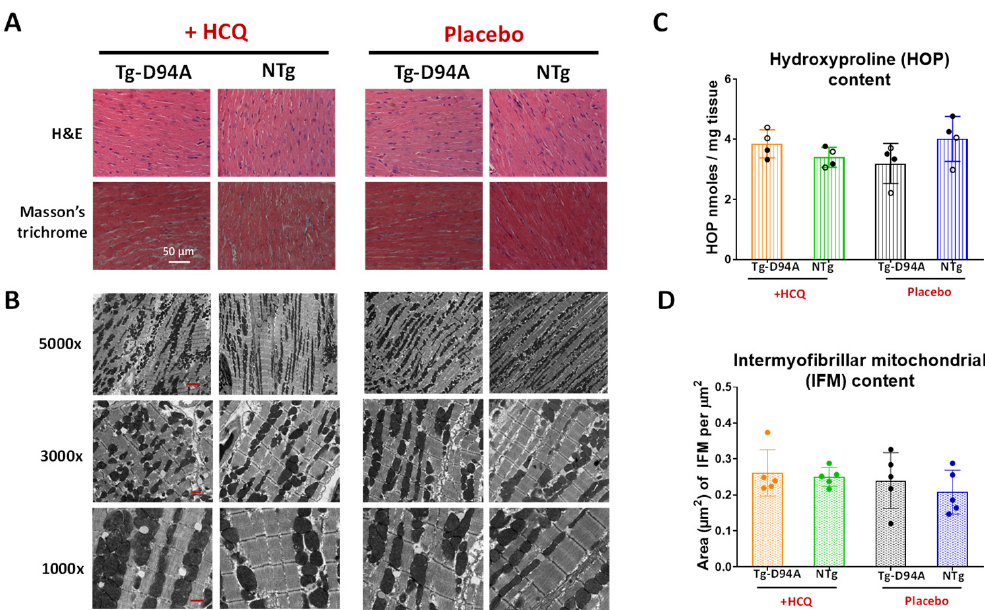
Figure 5. Histopathology and myocardial ultrastructure of the hearts of 6-mo-old Tg-D94A vs. NTg female mice treated with HCQ- vs. placebo. ( A ) Left ventricular (LV) samples stained with hematoxylin and eosin (H&E, upper panel) and Masson’s trichrome (bottom panel). ( B ) Transmission electron microscopy (TEM) images of sarcomeric ultrastructure of LV tissue of Tg-D94A and NTg mice. Images were taken at 1000×, 3000×, and 5000× magnification with scale bars of 4 µm, 1 µm, and 800 nm, respectively. Note some disrupted sarcomere structures and excessive vacuolar formations in the myocardium of Tg-D94A vs. NTg mice. ( C ) Quantification of fibrosis by hydroxyproline (HOP) assay. Data are presented as the mean ± SD (N o = 4 animals/group). ( D ) Assessment of intermyofibrillar mitochondrial (IFM) content in the hearts of Tg-D94A vs. NTg female mice treated with HCQ- vs. placebo at 3000 × magnification (scale bar 1 µ m). IFM data (in µ m 2 ) are presented as the mean ± SD (n = 5 images). No statistical significance was found in fibrotic content or IFM between HCQ- or placebo-treated groups by two-way ANOVA followed by Sidak’s multiple comparison test. ANF and BNP peptides are closely related to LV function and are sensitive markers of the severity of heart injury [21,22] and sensitive markers of pathological DCM pheno- type [23]. BNP and its N-terminal (NT)-prohormone (NT-proBNP) are released in